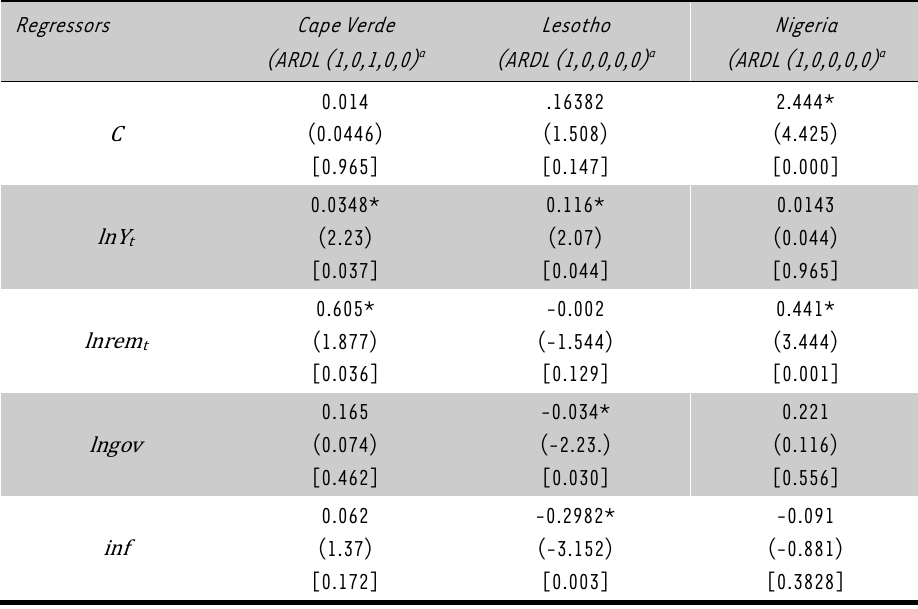
Estimated ARDL Long-Run